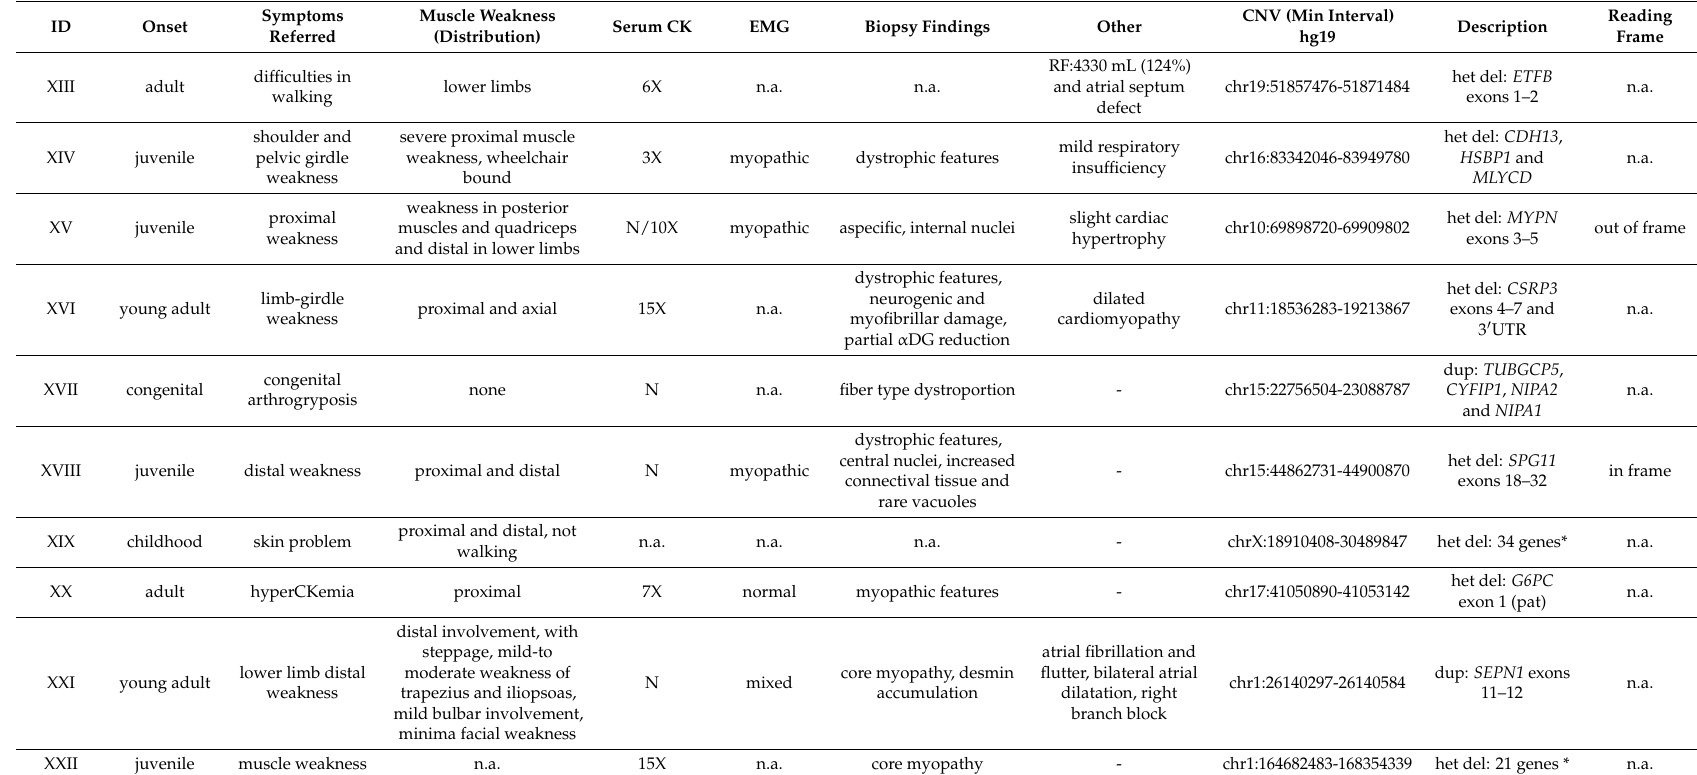
Table 2. Variants of uncertain